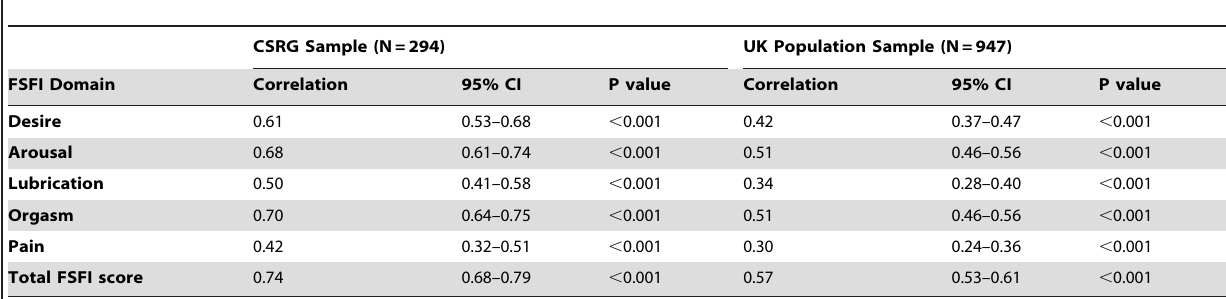
Table 5. Correlations of FSFI domain scores with sexual satisfaction scores among sexually active women with systemic sclerosis and sexually active women from a UK general population